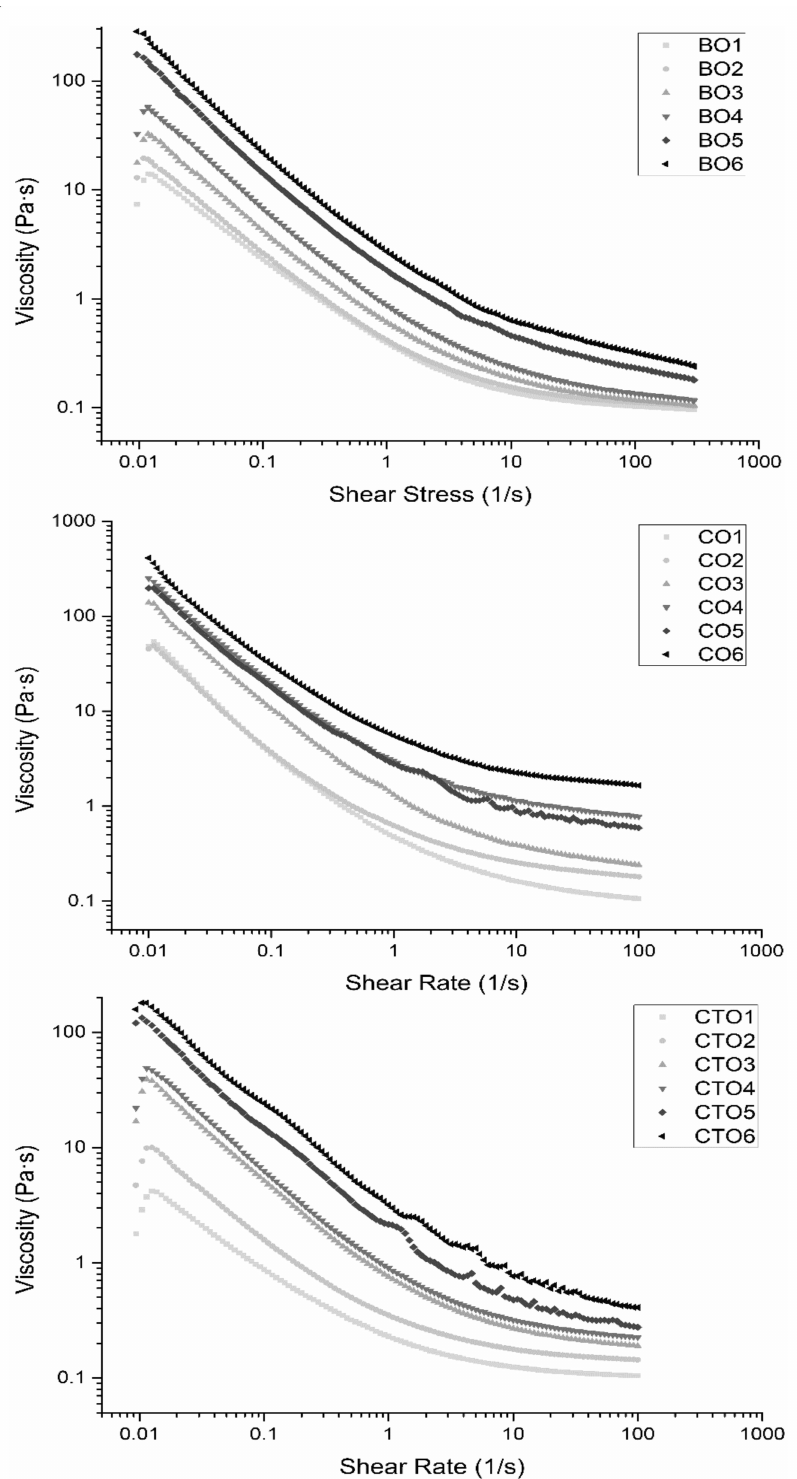
Figure 5. Flow curves for all organogel samples (up to 100